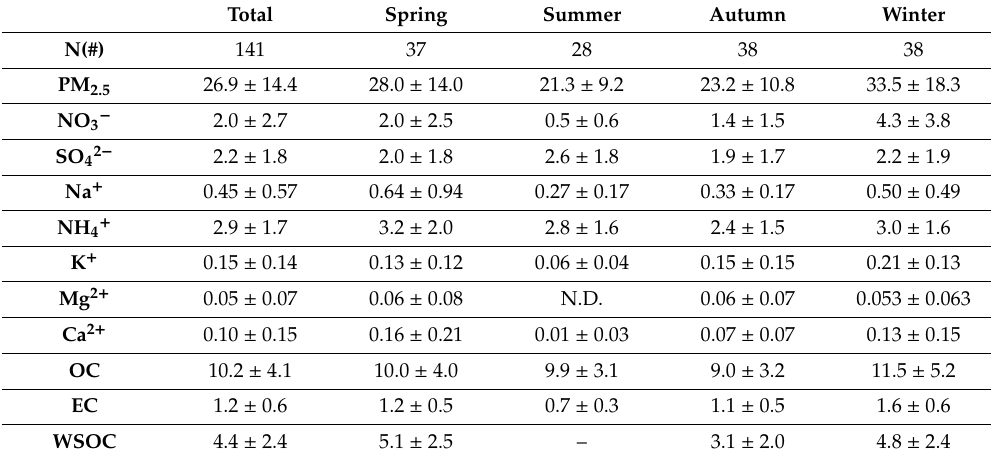
Table 3. Seasonal and annual average PM 2.5 mass concentrations and ionic components. Units of PM 2.5 and all components are µ g m − 3 .